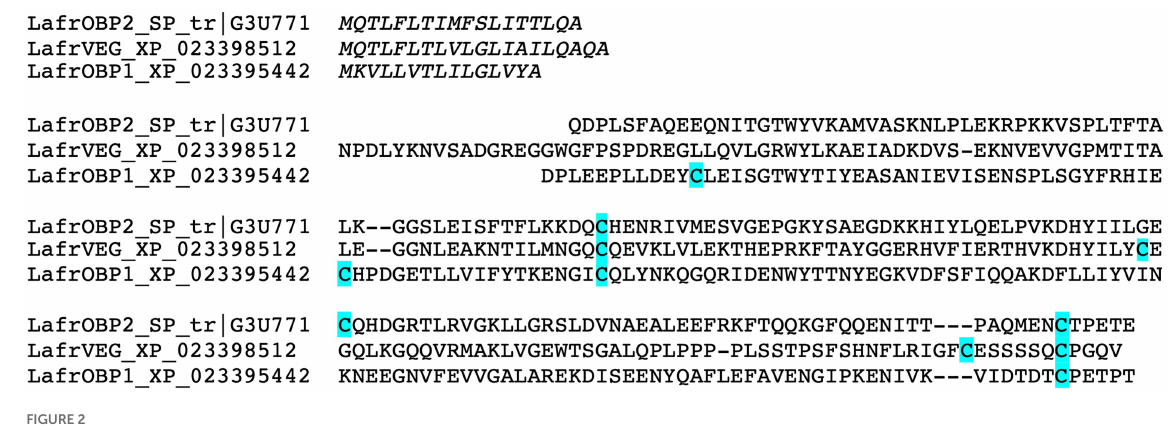
FIGURE 2 Sequence alignment of the three putative lipocalins which can be classified as semiochemical carriers in the African elephant. Cysteine residues are highlighted in blue. LafrOBP2 is only 15% identical to LafrOBP1, but is more similar to LafrVEG with 31% of common residues.